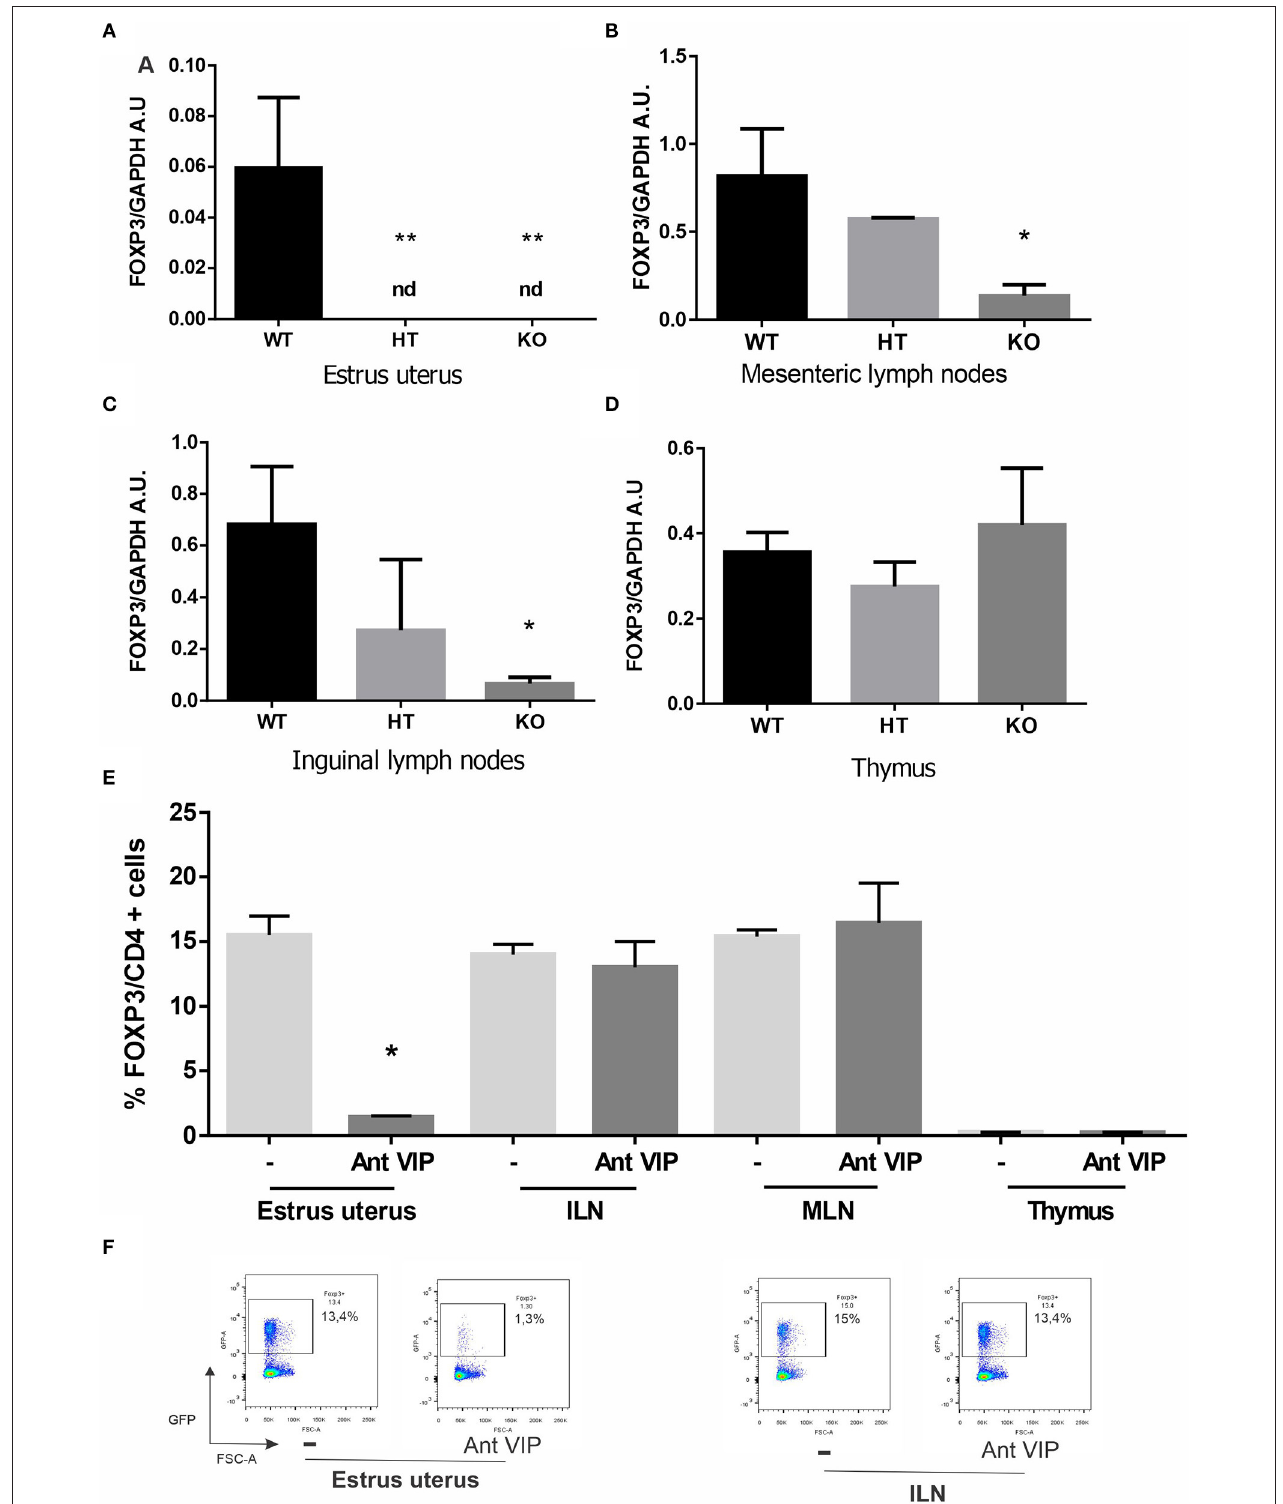
FIGURE 1 | Vasoactive intestinal peptide (VIP)-deficient mice show a reduction of FOXP3 expression, and VIP antagonist treatment decreases regulatory T cell (Treg) migration in wild-type (WT) estrus uterus. The estrous cycle was evaluated in VIP − / − , VIP + /–, VIP + / + , and FOXP3-GFP-knock-in females using vaginal